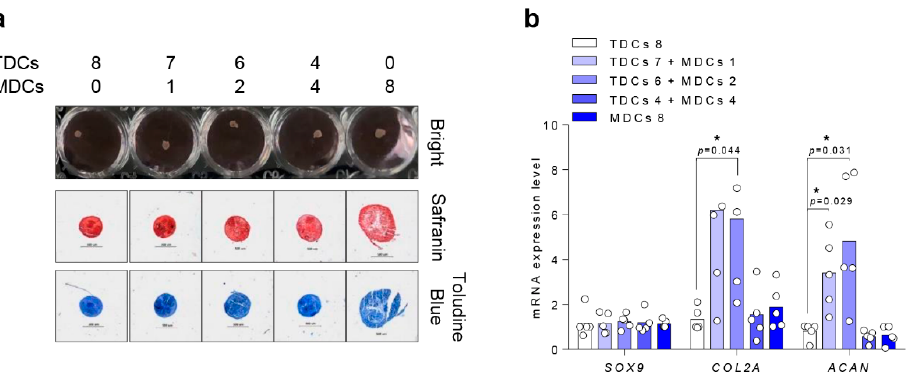
Figure 4. TDCs with a small population of MDCs contributes to induction of chondrocyte extracellular matrix genes under chondrogenic differentiation. A total of 2 × 10 5 cells/well (TDCs and/or MDCs, as indicated) were cultured in chondrogenic medium for two weeks and analyzed by ( a ) safranin O and toluidine blue staining (scale bar = 200 µm) and ( b ) RT-qPCR for differentiation markers. *, p < 0.05. Data are presented as the mean ± SEM.